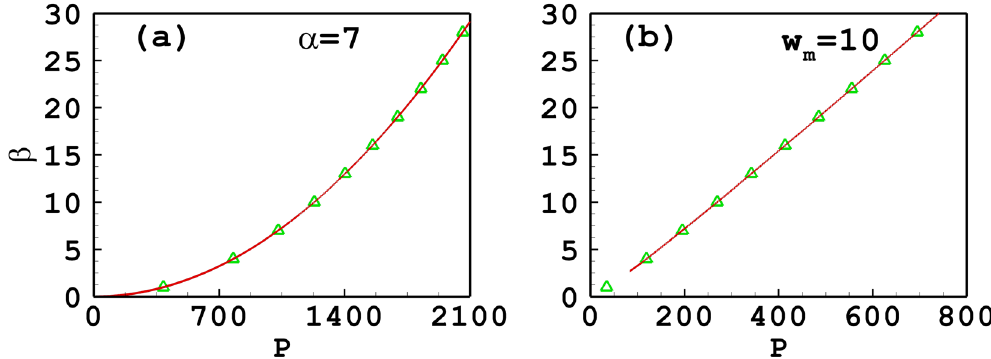
Figure 1. The propagation constant versus the power of tripole-mode solitons. ( a ) The degree of nonlocality is fixed at α = 7; ( b ) the width of the response function is fixed at w m = 10. The solid line and the triangles denote, respectively, the approximate solutions and the numerical ones.